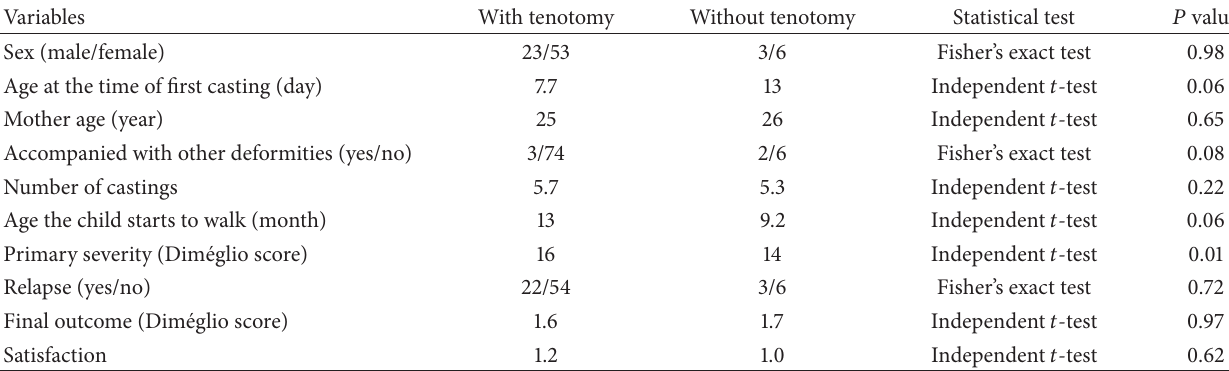
Table 3: Factors may be associated with further tenotomy in clubfeet managed with Ponseti method.